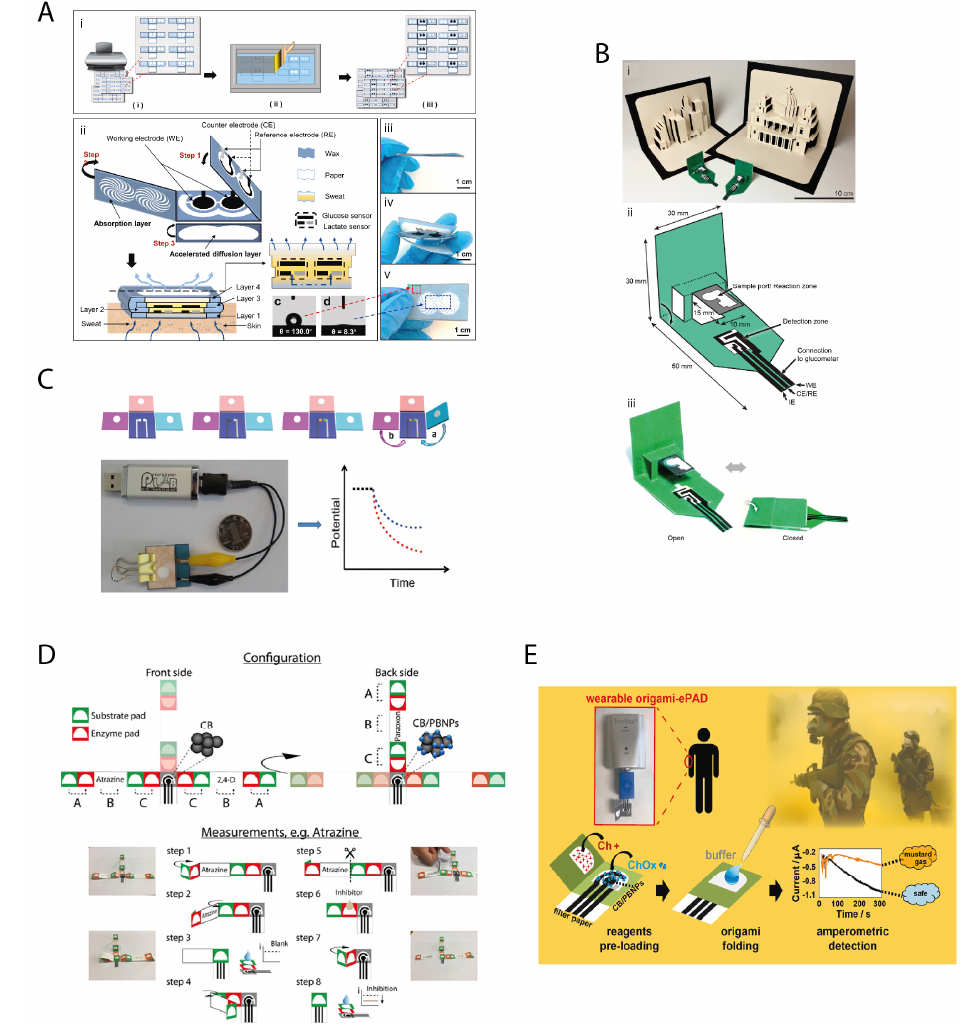
Figure 1. ( A ) A highly integrated sensing paper for wearable electrochemical sweat analysis. Re-